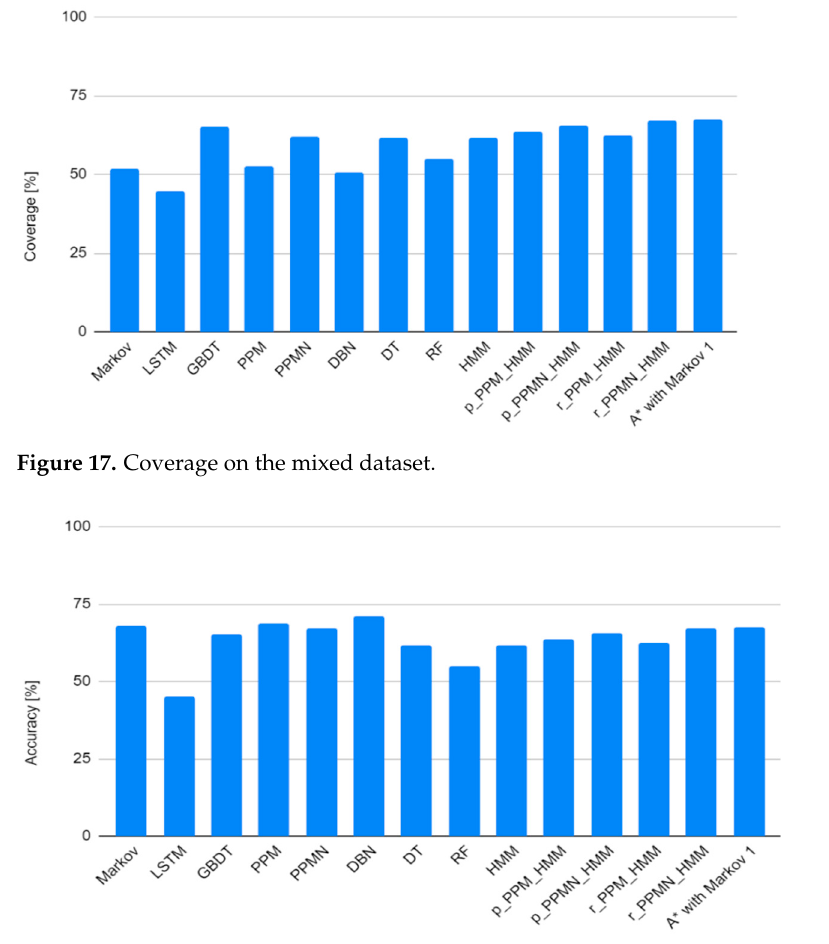
Figure 18. Accuracy on the mixed dataset.